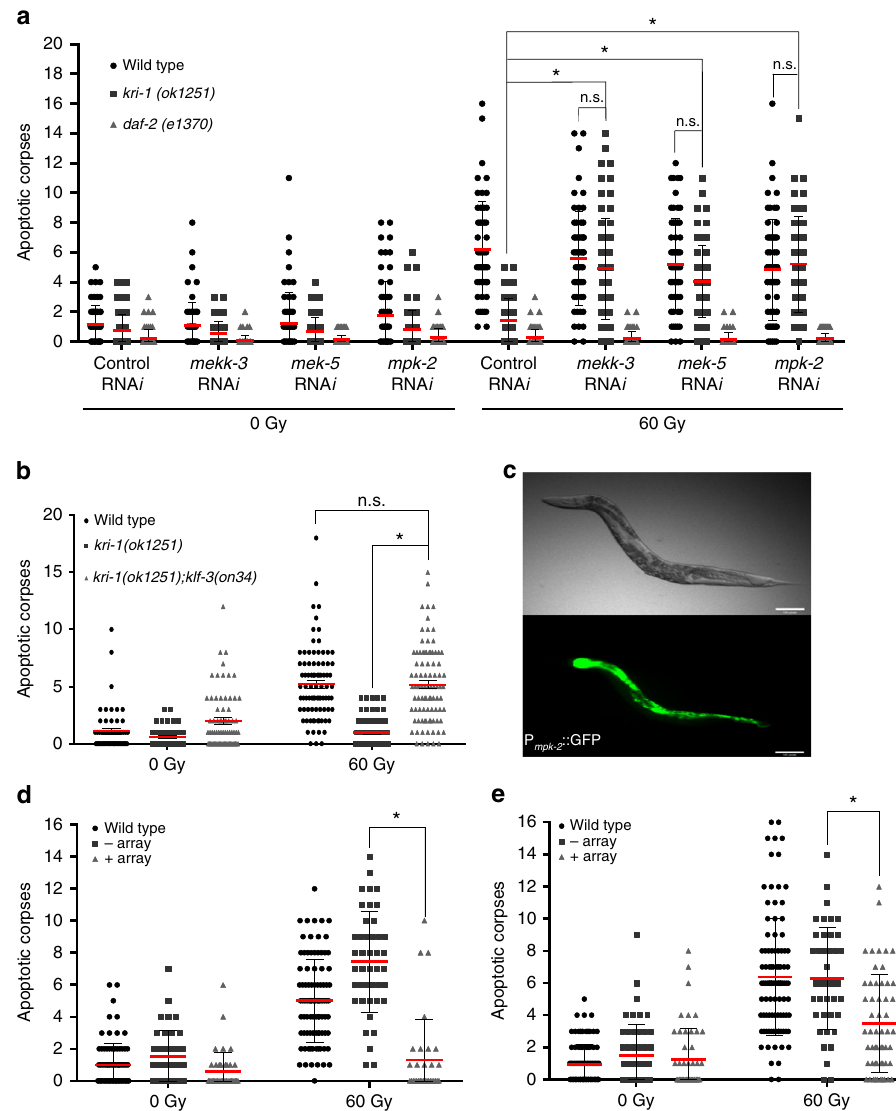
Fig. 3 MPK-2/ERK5 and KLF-3 regulate IR-induced apoptosis downstream of KRI-1. a IR-induced germline apoptosis scored after knock-down of the ERK-5/ MAPK pathway genes, mekk-3, mek-5 , and mpk-2 in wild type, kri-1(ok1251) and daf-2(e1370) animals ( n ≥ 60). b IR-induced germline apoptosis scored in wild type, kri-1(ok1251) , and kri-1(ok1251); klf-3(on34) animals ( n ≥ 45). c Expression of P mpk-2 ::gfp . Images are representative of three independent lines (×100 magni fi cation). Scale bar is 50 μ m. d IR-induced germline apoptosis scored in wild type, P mpk-2 ::mpk-2 “ + array ” , and P mpk-2 ::mpk-2 siblings that have lost the transgene “ − array ” ( n ≥ 30). e IR-induced germline apoptosis scored in wild type, P elt-2 ::mpk-2 “ + array ” , and P elt-2 ::mpk-2 siblings that have lost the transgene “ − array ” ( n ≥ 30). a – e Red line is mean ± standard deviation. * P < 0.05, two-sided, unpaired t